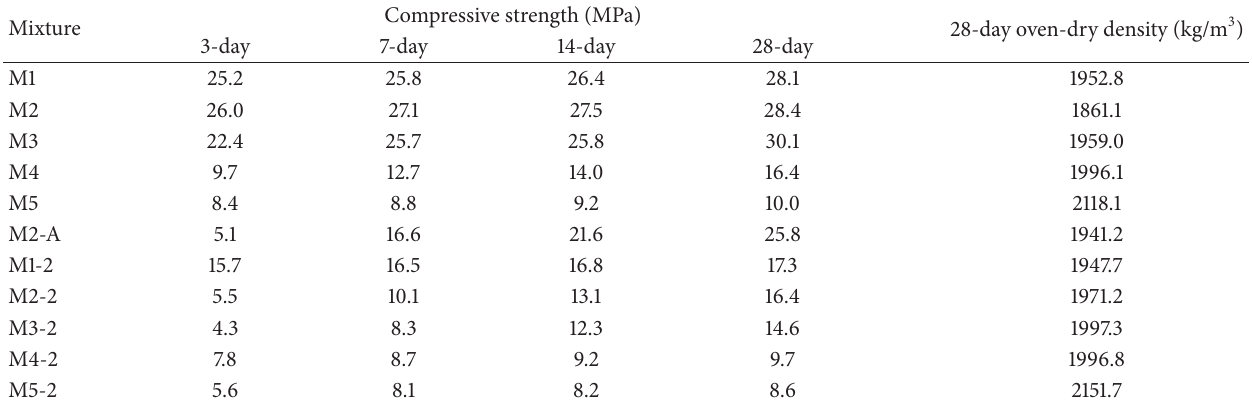
Table 5: Development of compressive